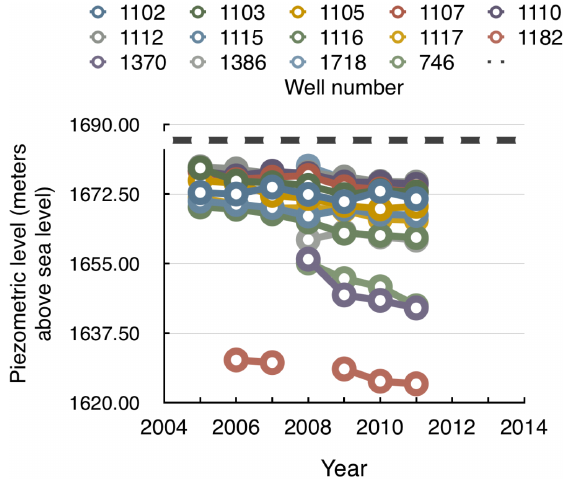
Figure 2. Piezometric level evolution for the time interval between 2005 and 2011 for selected extraction wells measured around the Rincón de Parangueo maar. Location of the wells is indicated in Fig. 1.